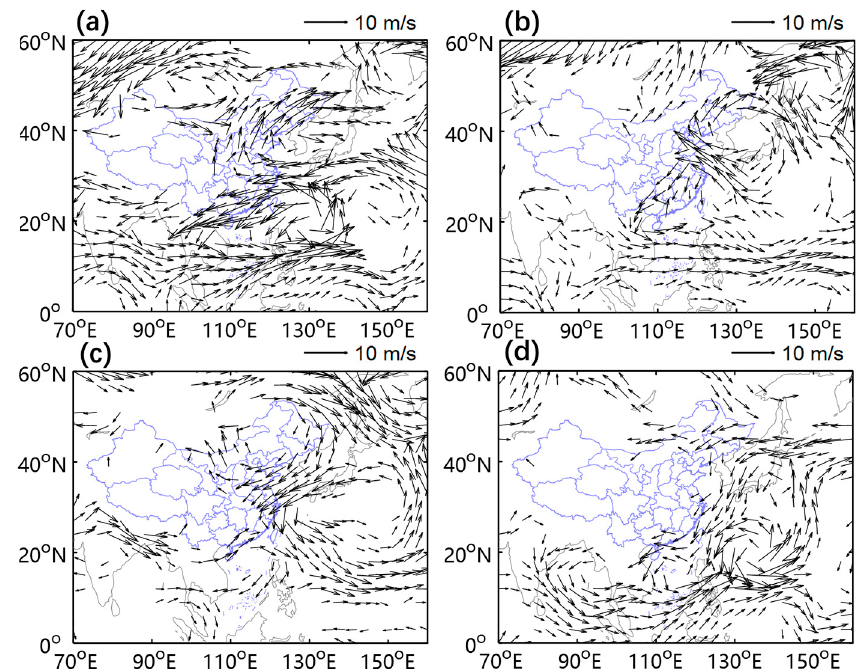
Figure 5. Composite 850-hPa horizontal wind anomalies (vectors; units: m/s) for ( a ) hot period 1, ( b ) hot period 2, ( c ) hot period 3 and ( d ) hot period 4. Only wind vectors larger than 2 m/s are shown.